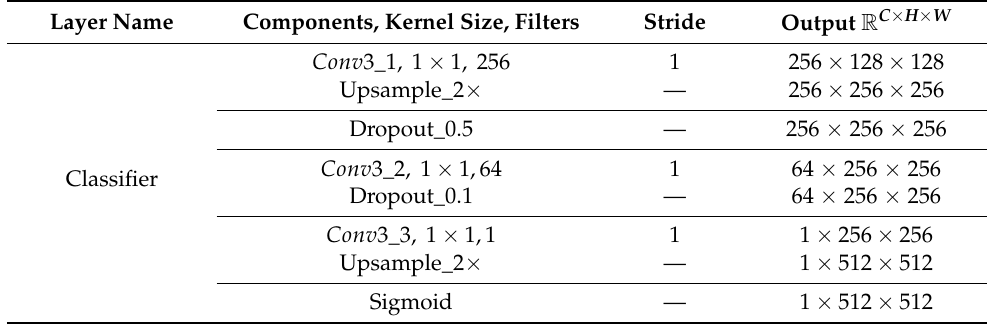
Table 3. The detailed architecture of the 1M-CDNet